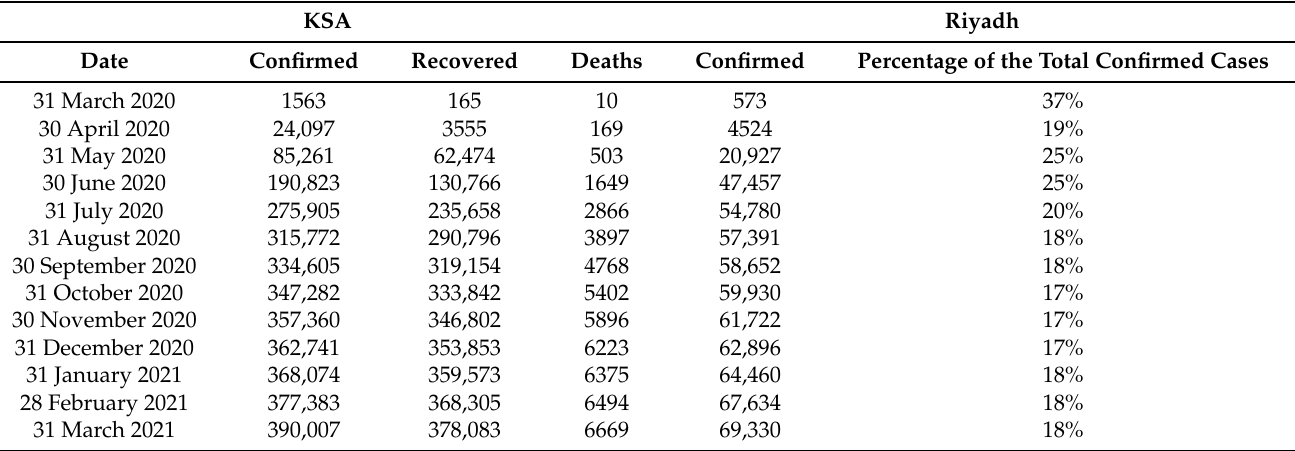
Table 2. Cumulative numbers at the end of each month in Saudi Arabia and Riyadh for confirmed, recovered, and death cases of COVID-19. KSA